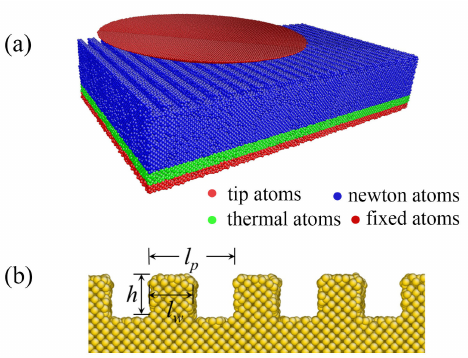
Figure 1. The friction model for the nanopatterned silicon surface contact using a spherical diamond tip: ( a ) Three-dimensional view, and ( b ) schematic of the